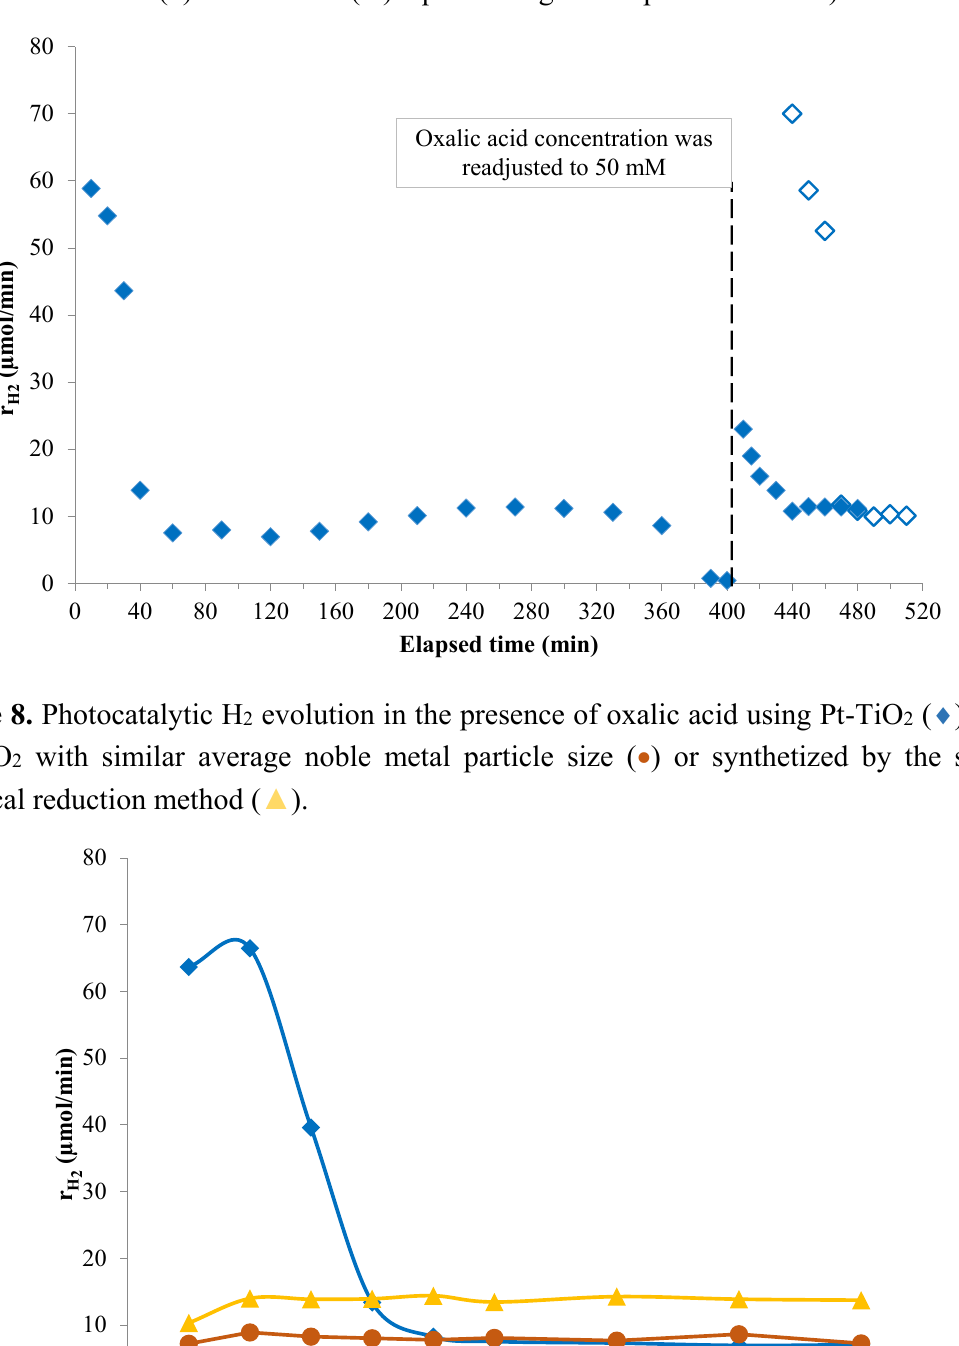
Figure 7. Long term irradiation of Pt-TiO 2 in the presence of oxalic acid (initial concentration = 50 mM; oxalic acid concentration was re-adjusted after complete mineralization with (◊) and without (  ) equilibrating the suspension in dark).